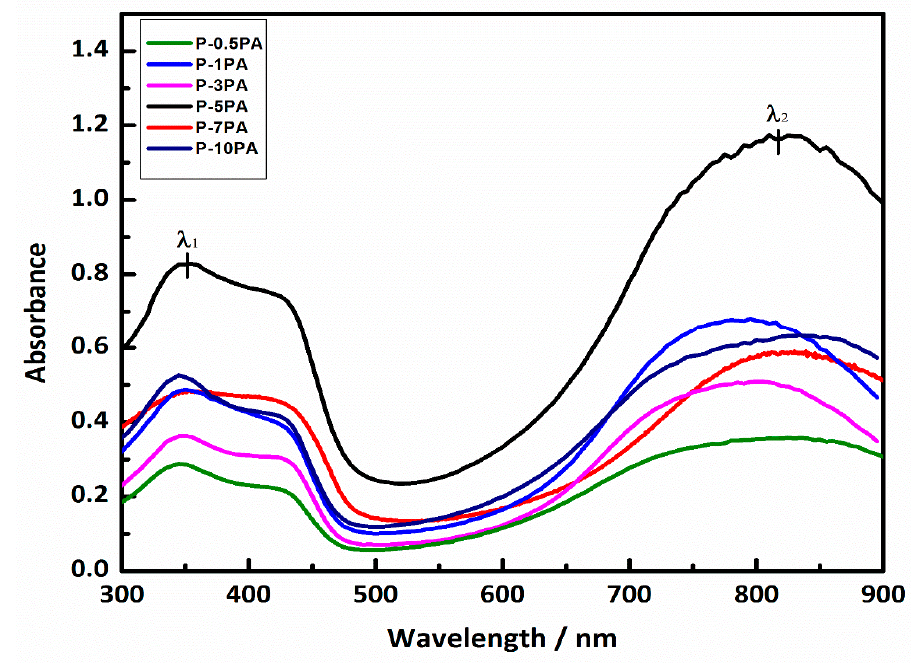
Figure 3. UV-vis spectra of the sodium phytate doped PANI Figure-3. UV-vis spectra of the sodium phytate doped PANI samples.